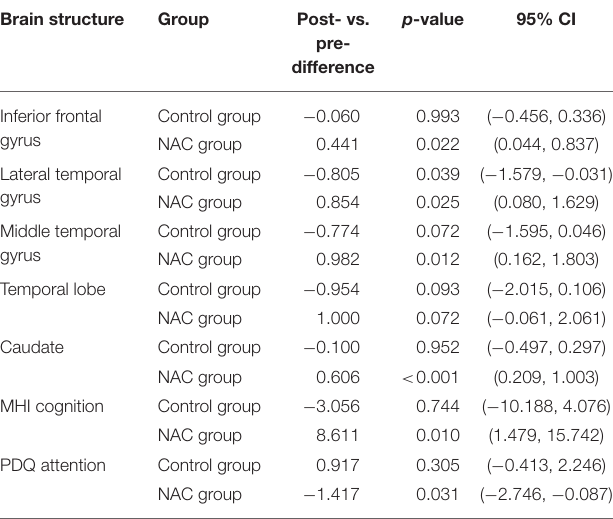
Frontiers in Neurology |